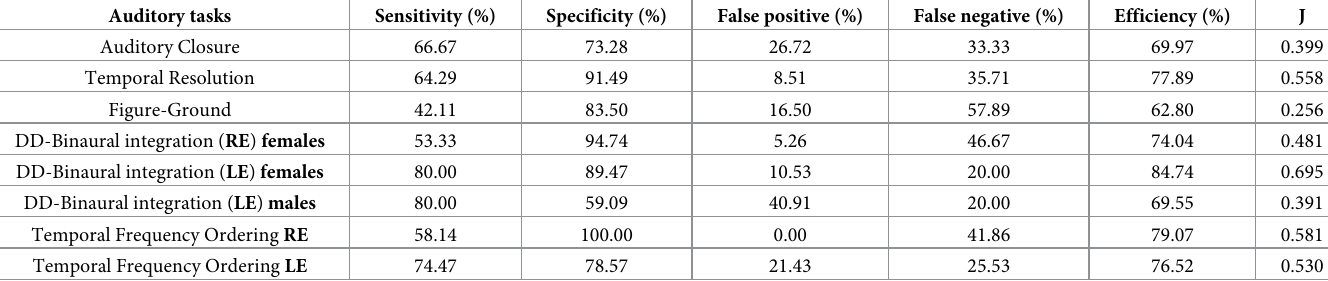
Table 3. Performance of schoolchildren in the 6- to 7-year-old age group in AudBility and values of sensitivity, specificity, and efficiency. Auditory tasks